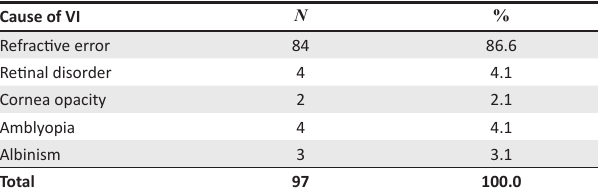
TABLE 4: Causes of visual impairment.